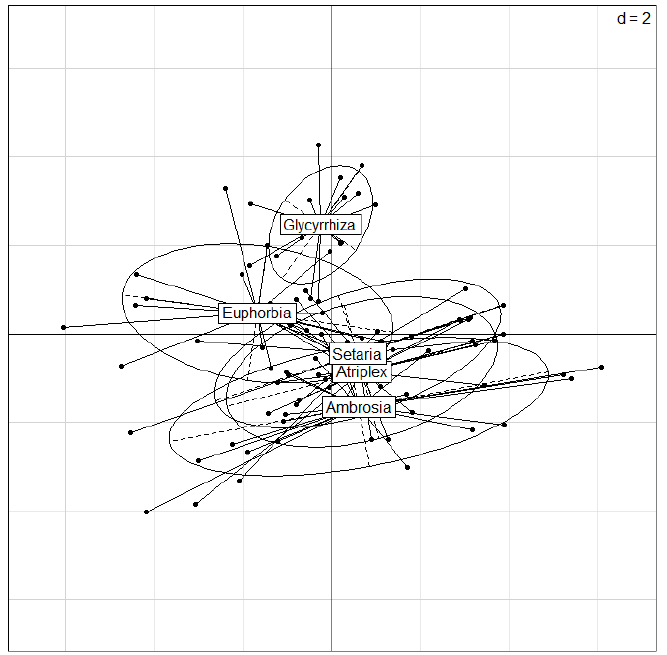
Figure 14. Wavelength DT for Ambrosia artemisiifolia , Atriplex tatarica , Glycyrrhiza glabra , Euphorbia seguieriana , and Setaria pumila .